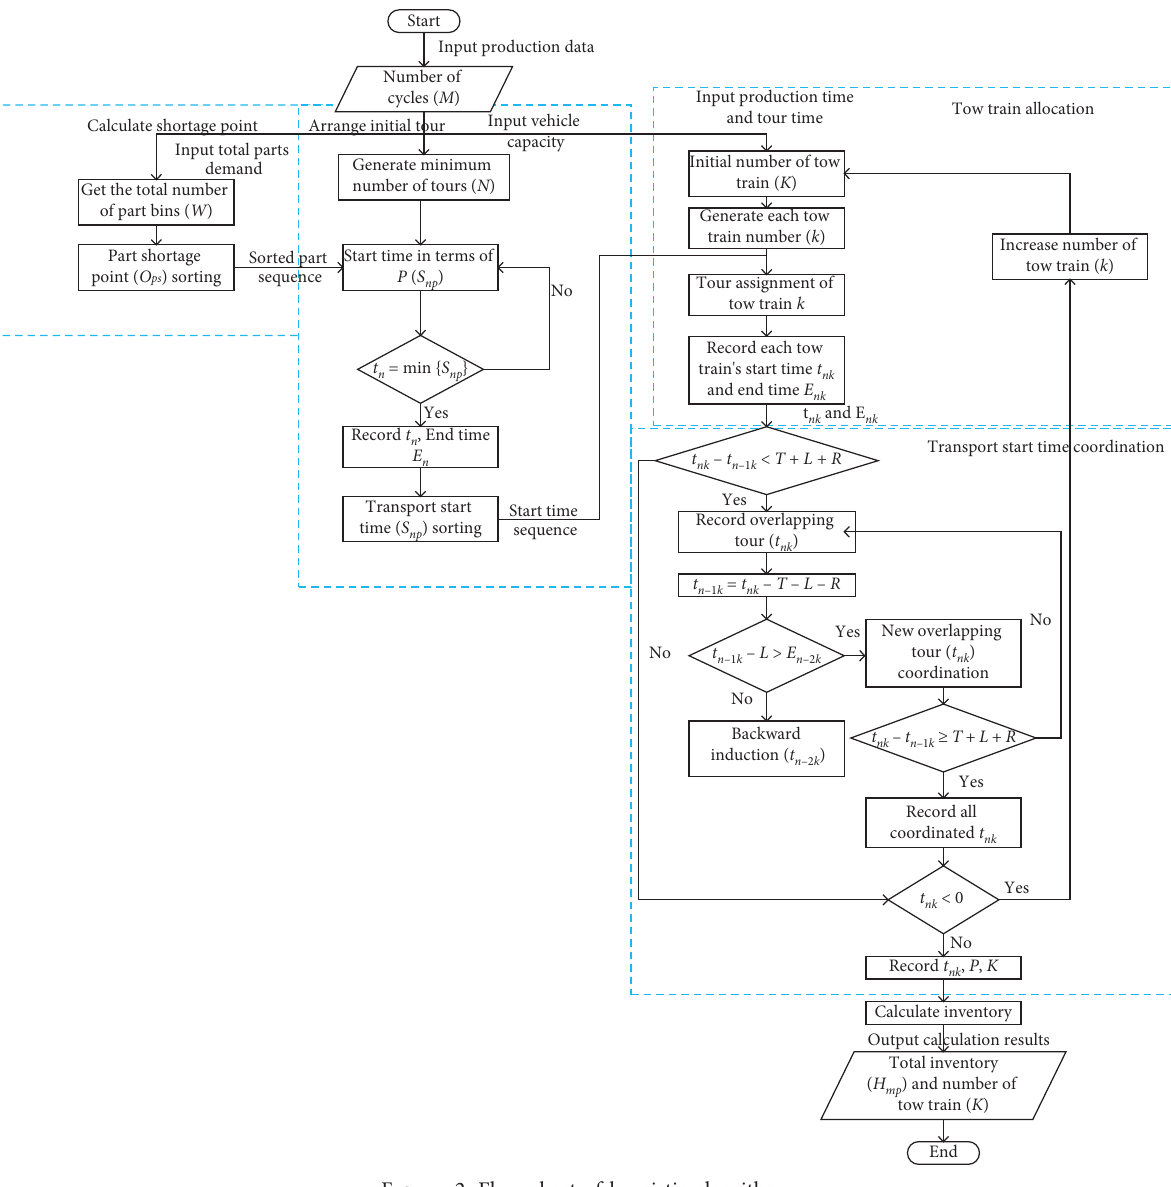
Figure 2: Flow chart of heuristic